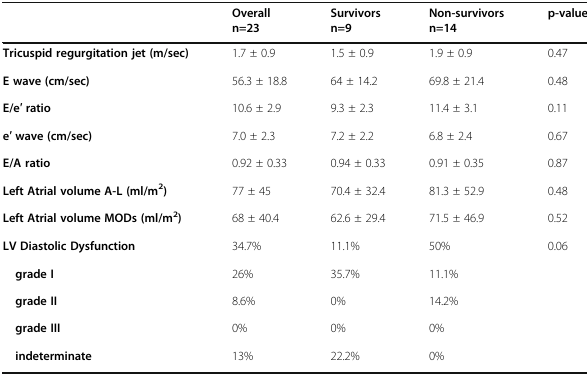
Table 1 (abstract A121). Evaluation of Left Ventricular (LV) diastolic dysfunction in patients with coronavirus disease admitted to intensive care and receiving advanced echocardiography. A-L: area-length method. MODs: Method of